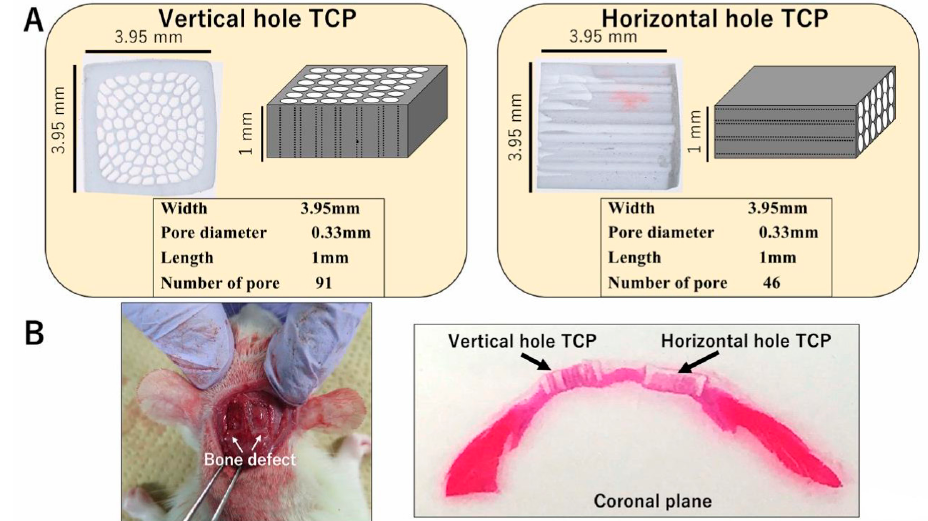
Figure 1. ( A ) Photographs and diagrams of vertical and horizontal β -tricalcium phosphates ( β -TCPs). ( B ) β -TCP inserted into the skull bone defect of an experimental